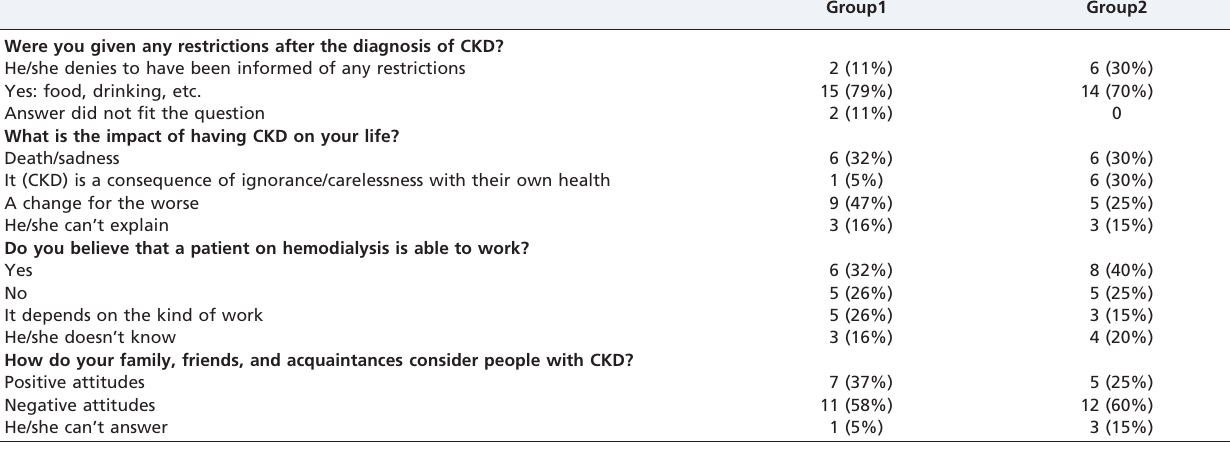
Table 4 - Impact of having chronic renal